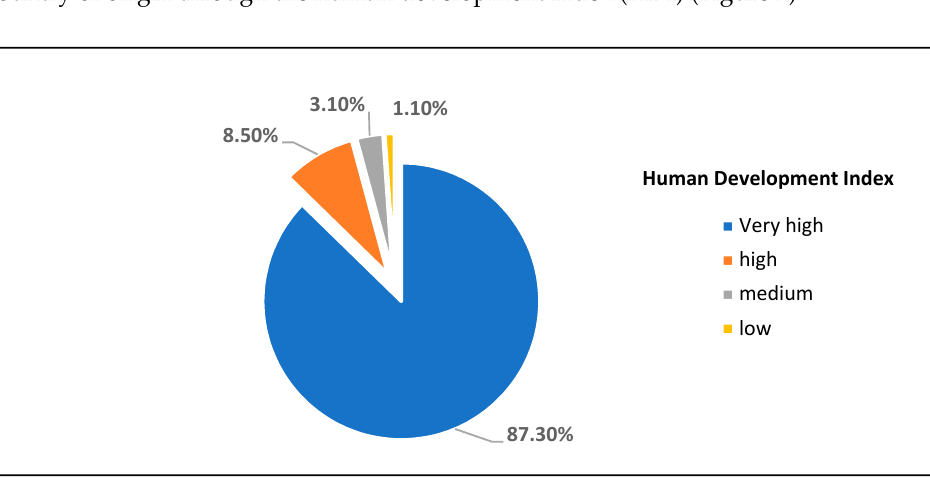
Figure 1. Characteristics of the sample in relation to age. As for the work performance of the sample members, 55.4% ( n = 554) belong to the health sector, 32.9% ( n = 329) to the educational field and 11.7% ( n = 117) to the economy sector. The socioeconomic level of the sample members has been established based on the country of origin through the human development index (HDI) (Figure 2).